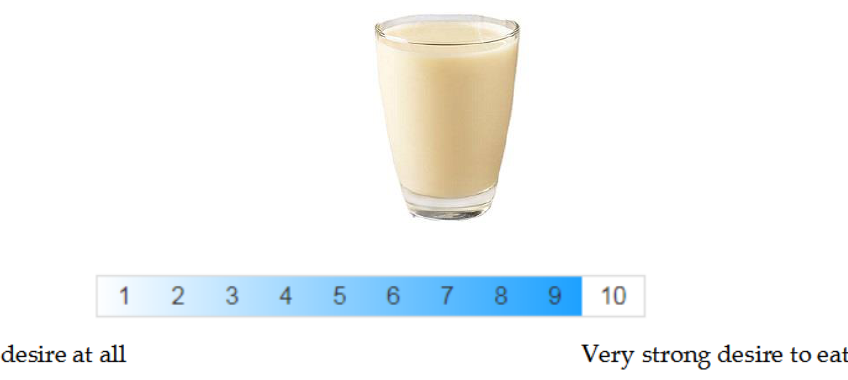
Figure A2. The picture of soy products (Liquid food).